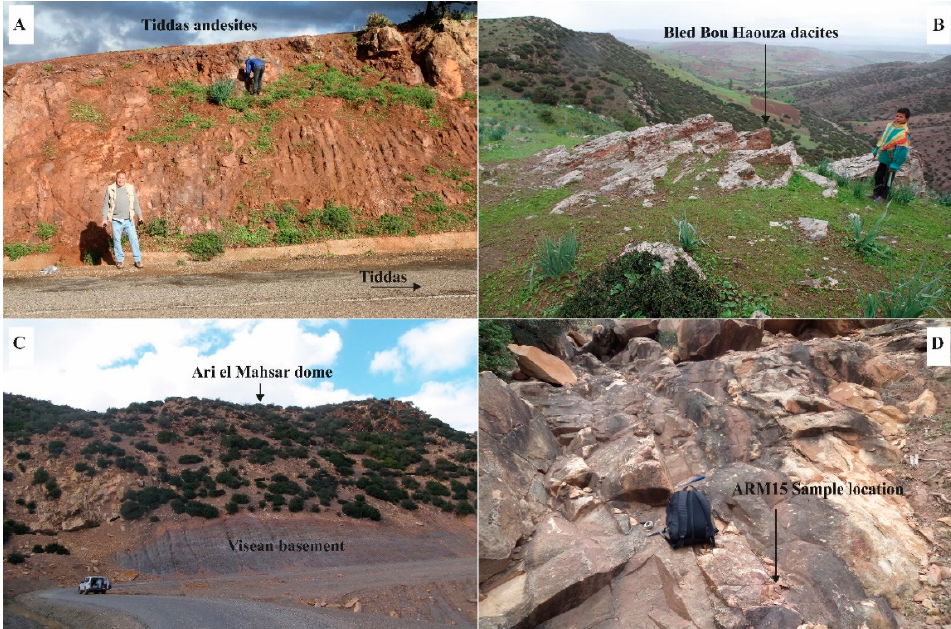
Figure 3. Field photographs: ( A ) Tiddas andesites located to the SW of this village; ( B ) dacites of Bled Bou Haouza located to the SE of Sebt Ait Ikko; ( C ) Ari el Mahsar dome laying on the Visean basement; ( D ) a close view of the rhyolites in the Ari el Mahsar dome. The location of sample ARM15 is indicated.